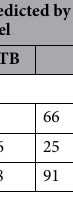
Table 3. Confusion matrix report for